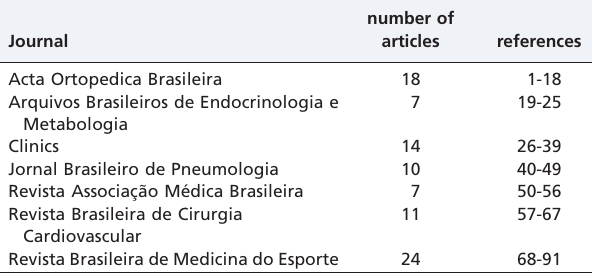
Table 1 - Distribution of articles by publication source.